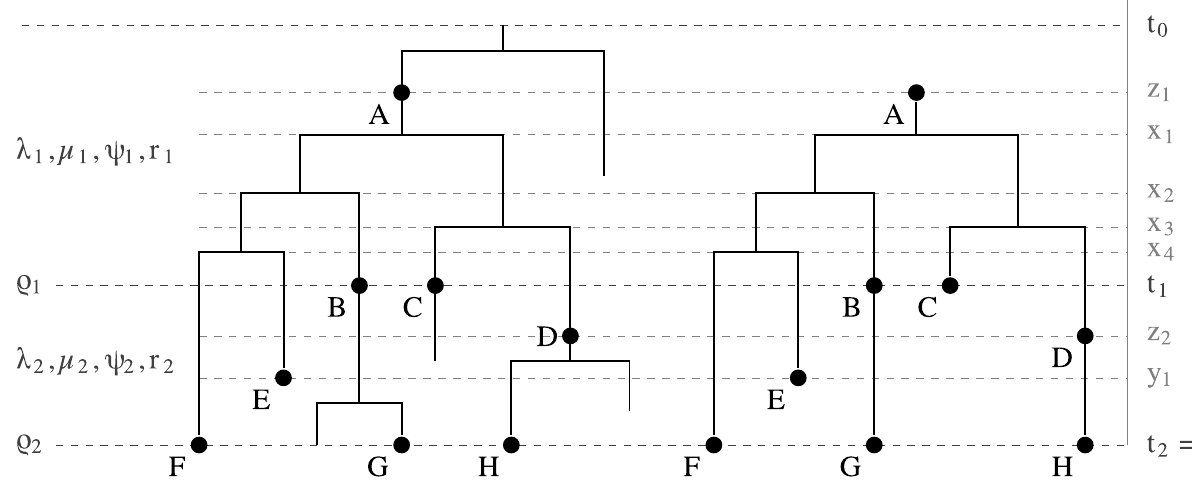
Figure 1. Full tree versus reconstructed tree. A full tree produced by the sampled ancestor birth-death process on the left and a reconstructed tree on the right. The sampled nodes are indicated by dots labeled by letters A through H. Nodes A, B and D are sampled ancestors. The reconstructed tree is represented by a sampled ancestor tree g ~ ( T ,( x 1 , x 2 , x 3 , x 4 , y 1 , z 1 , z 2 )) , where T denotes the ranked tree topology and (cid:2) xx , (cid:2) yy , and (cid:2) zz denote the node ages. In the reconstructed tree the root is a sampled node. In the skyline model, birth-death parameters vary from interval to interval. There are two intervals in this figure bounded by the time of origin t 0 , parameter shift time t 1 , and present time t 2 . Between t 0 and t 1 parameters l 1 , m 1 , y 1 and r 1 apply and between t 1 and t 2 parameters l 2 , m 2 , y 2 , and r 2 . There are additional sampling attempts at times t 1 and t 2 with sampling probabilities